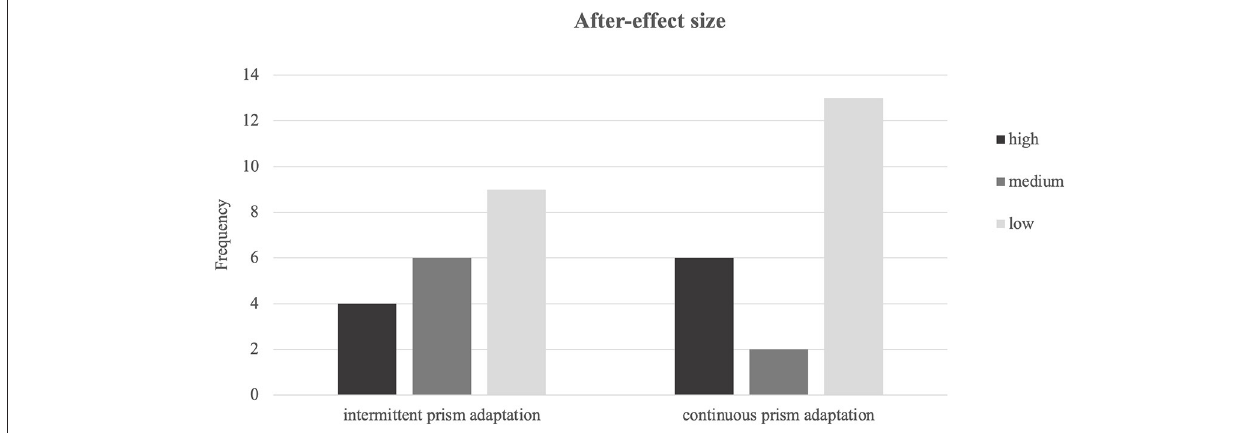
FIGURE 4 | Frequencies of after-effect sizes for intermittent and continuous prism adaptation training categorized into low, medium, and